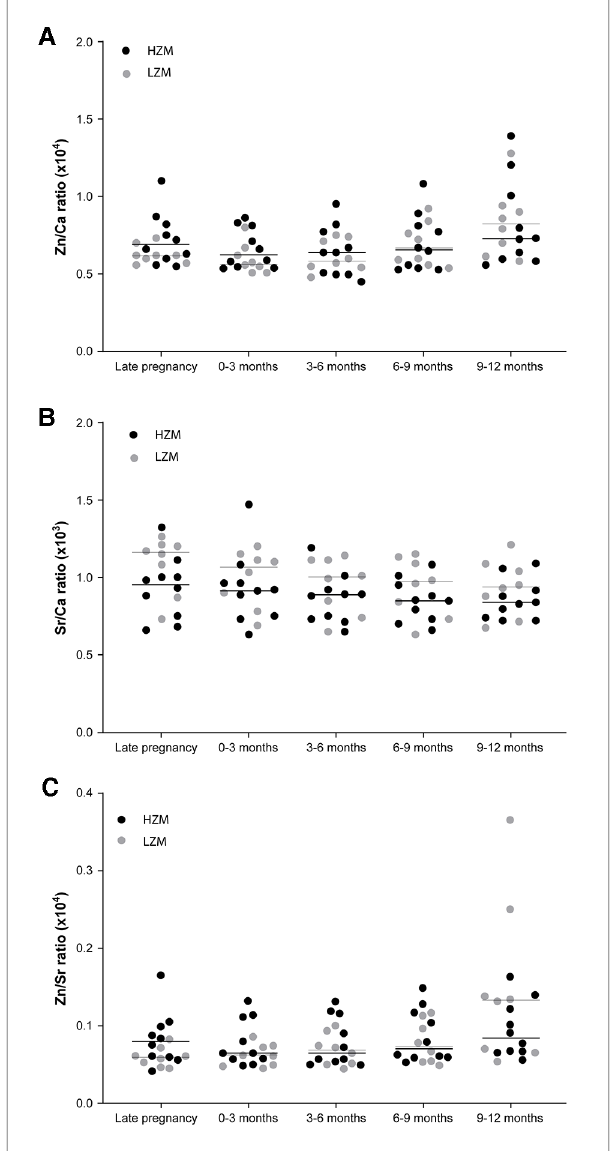
FIGURE 5 Ratios of Zn, Sr and Ca across different points in time during the development of deciduous teeth shown as scatter plots with data points coded for mothers classi fi ed as consumers of a high zinc (HZM; n =10) or low zinc (LZM; n =8) diet during pregnancy. Medians are shown as horizontal bars. ( A ) Data expressed as Zn/Ca ratios. ( B ) Data expressed as Sr/Ca ratios. ( C ) Data expressed as Zn/Sr ratios; p < 0.001, 2-way ANOVA; * p <0.05 for HZM vs. LZM (Holm-Sidak post hoc